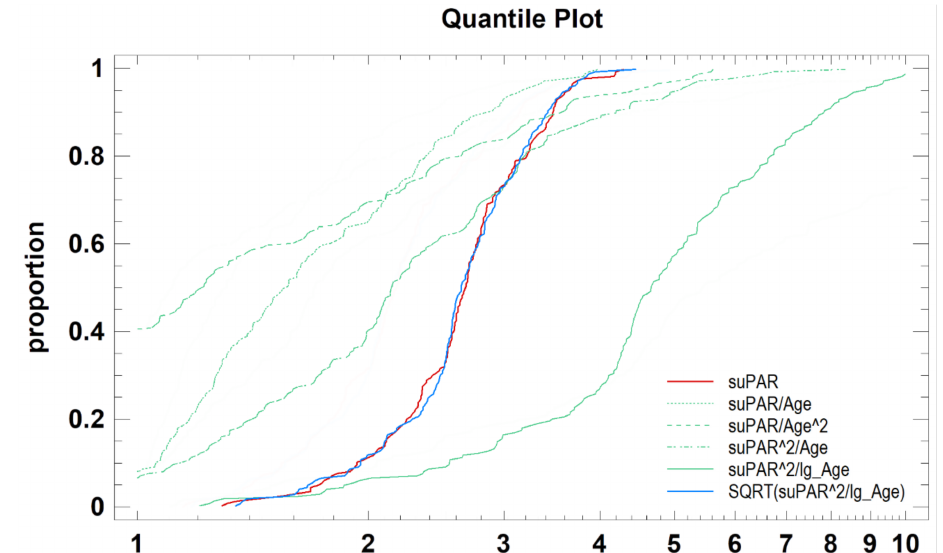
Figure 3. Values of calculated indeces. The search for body inflammation index-to make the suPAR level independent on patient age together with similar representation of variability. Accurate presentation of differences in suPAR distribution (age dependent variable: cc = 0.39; p < 0.0001) and a series of indeces distributions that make the result independent of the patient’s age (as SQRTsuPARˆ2/lg_Age calculated). Note: The calculations were based on indeces calculated according to the Equations (1)–(5).